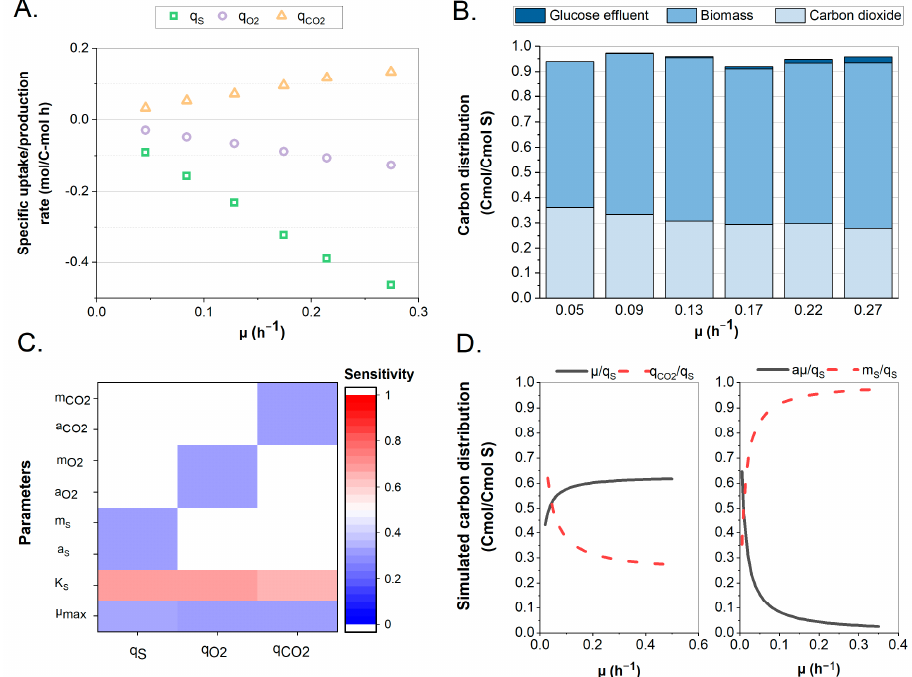
Figure 2. Observed and simulated growth kinetics of Y. lipolytica W29. ( A ) Specific consumption rates of substrate (q S ) and oxygen (q O2 ) and production rates of carbon dioxide (q CO2 ) were plotted from the values obtained from a continuous cultivation at six dilution rates. ( B ) Observed carbon balance and substrate distribution at various dilution rates of the continuous cultivation. ( C ) Sensitivity analysis of model kinetic parameters using the total Sobol indices. ( D ) (LEFT) Simulated values of substrate distribution to biomass production (Y X/S ) and to CO 2 production (Y CO2/S ). (RIGHT) Simulated values of growth-dependent (a S µ/q S ) and maintenance-dependent (m S /q S ) glucose uptake.